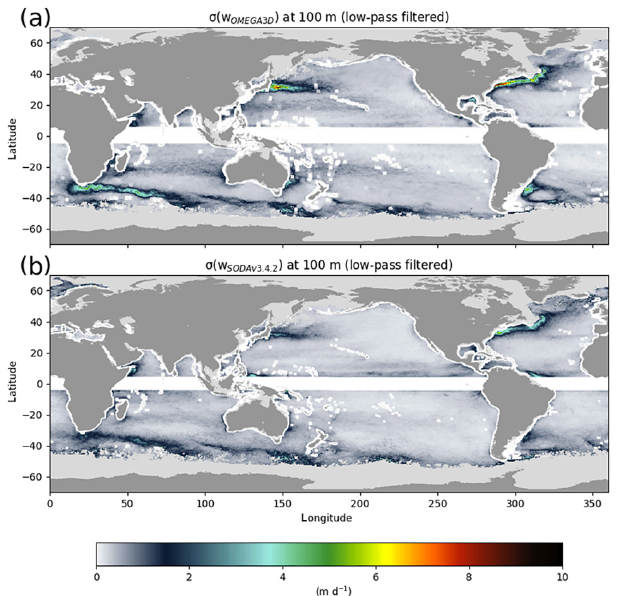
Figure 2. Mean monthly vertical velocity patterns and standard de- viations computed from OMEGA3D (a) and SODAv3.4.2 (b) after low-pass filtering the time series to remove signals above monthly frequency.